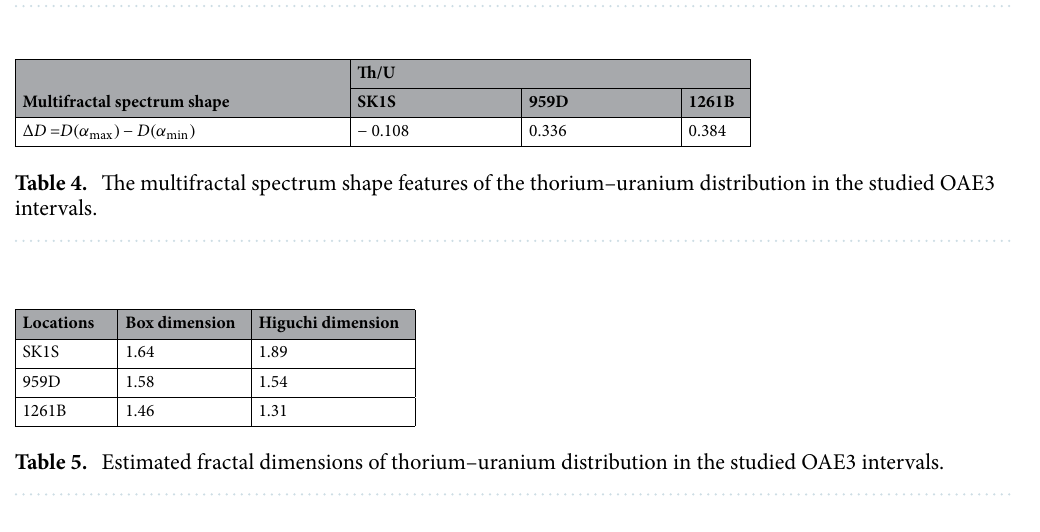
Figure 10. OAE3 paleo-redox conditions characterization in Songliao Basin, Deep Ivorian Basin and Demerara Rise based on thorium–uranium cross-plot. Th/U < 2 represents a reducing environment; Th/U > 7 represents an oxidizing environment; 2 < Th/U < 7 represents a transitional period between oxidizing and reducing environment.